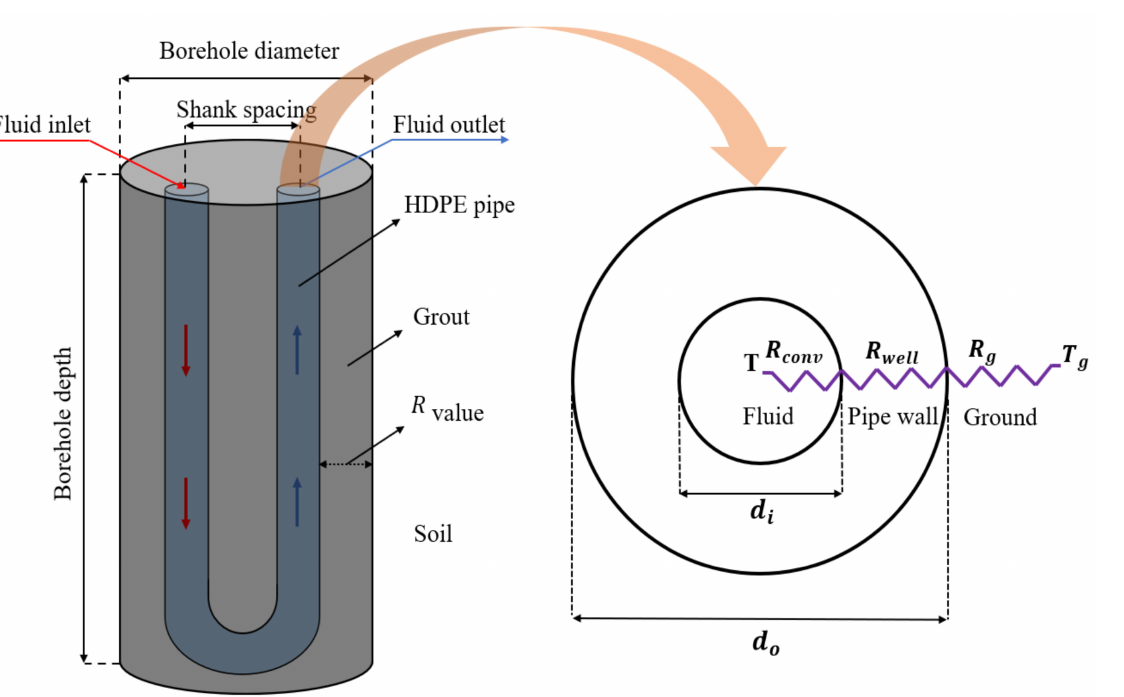
Figure 4. Schematic diagram of a vertical single U-tube ground heat exchanger (GHE) configu- ration, where d i is pipe inner diameter, d o is pipe outer diameter, T is temperature, R conv is fluid thermal resistance, R wall is pipe wall’s thermal resistance, R g is ground thermal resistance, and T g is ground